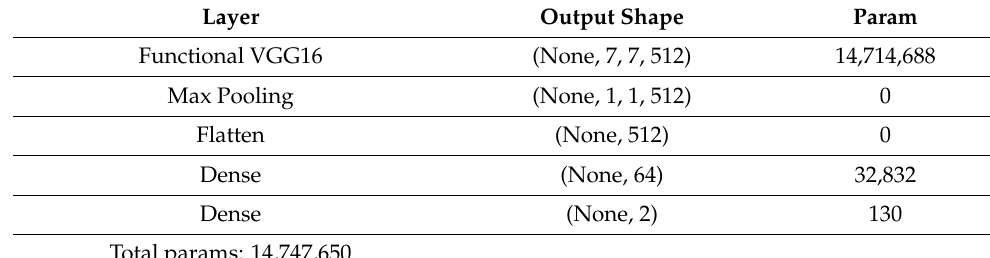
Figure A2. Limited-trained network architecture. Table A1. Limited-trained model’s characteristics. Table A2. Limited-trained model’s summary. Table A2. Limited-trained model’s summary.